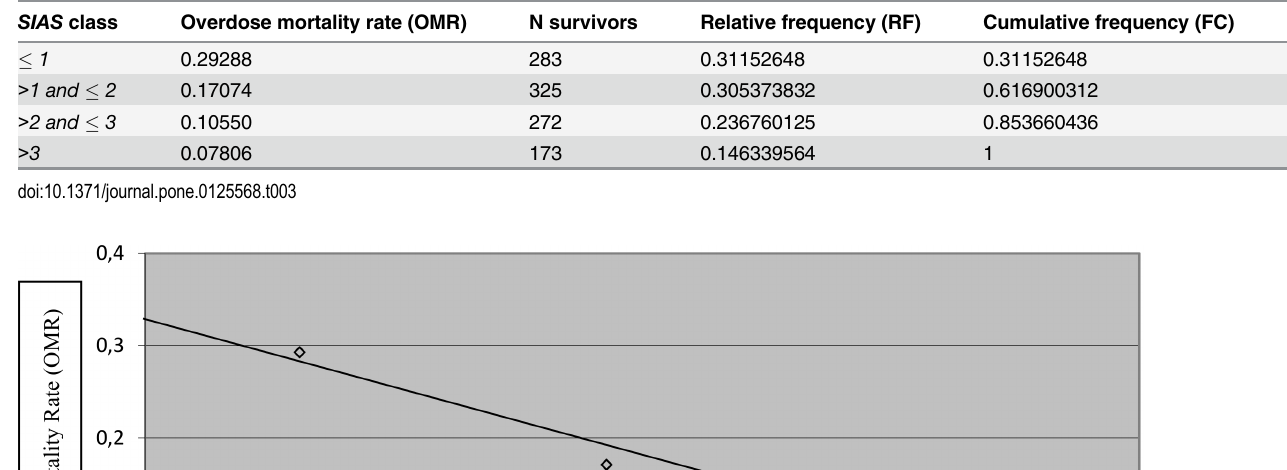
Table 3. Overdose mortality rates and ridit scores associated to SIAS